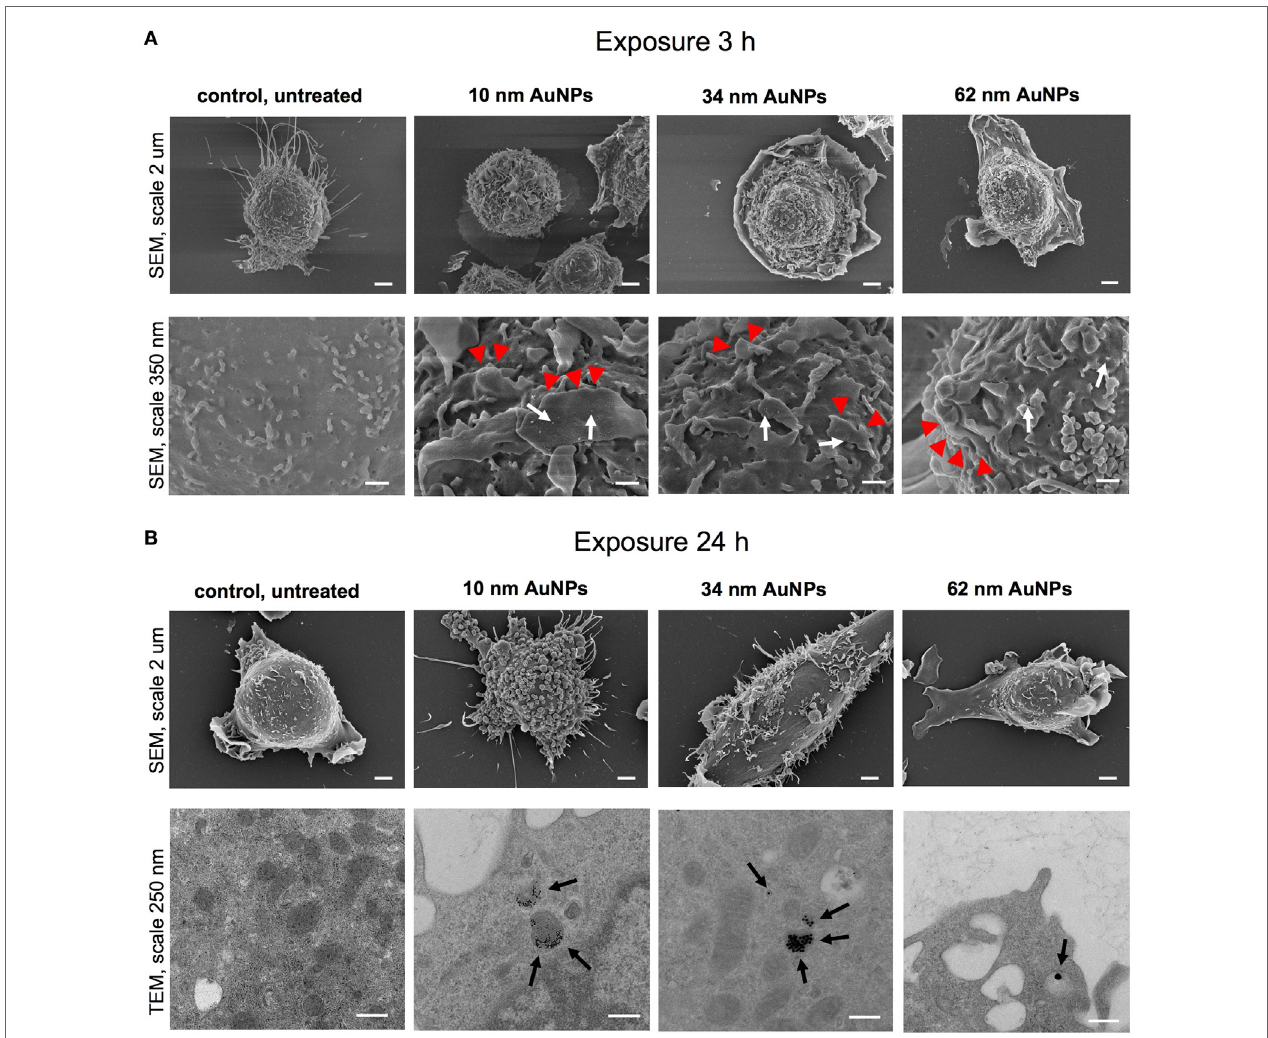
FigUre 4 | Scanning electron microscopy (SEM) and transmission electron microscopy (TEM) images of JAWS II cell line after 3 (a) and 24 h (b) of incubation with 5 µg/ml 10, 34, and 62 TA-AuNPs. White arrows indicate deposition of NPs, red arrowheads indicate lamellipodia, while black arrows point to intracellular deposits of AuNPs. Bars 2 μ m, 250 nm and 350 nm are